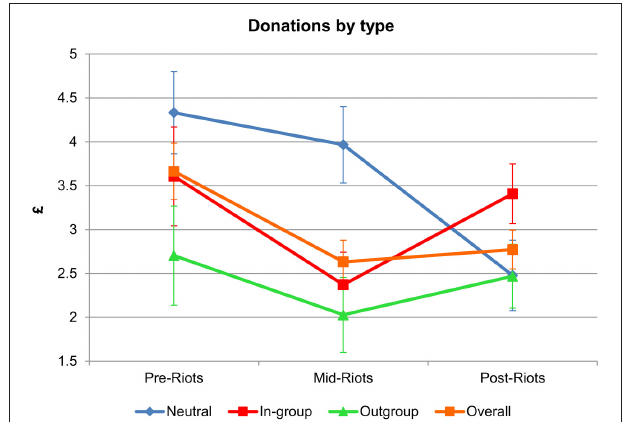
FIGURE 2 | Predicted donations by type over time. Predicted value (£) of an individual donating to the neutral charity Save the Children , an in-group primary school, an out-group primary school and all combined donations over time (before, during, and after the riots). These predicted values are controlled for individual household income, educational level, age, gender and religion. Error bars represent the standard